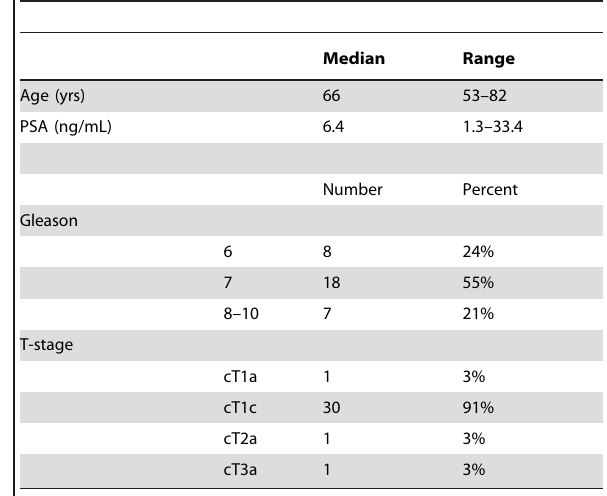
Table 1. Clinical characteristics of the validation prostate cancer